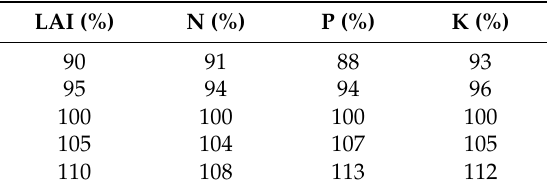
Table 12. The results of error propagation from LAI to SAN